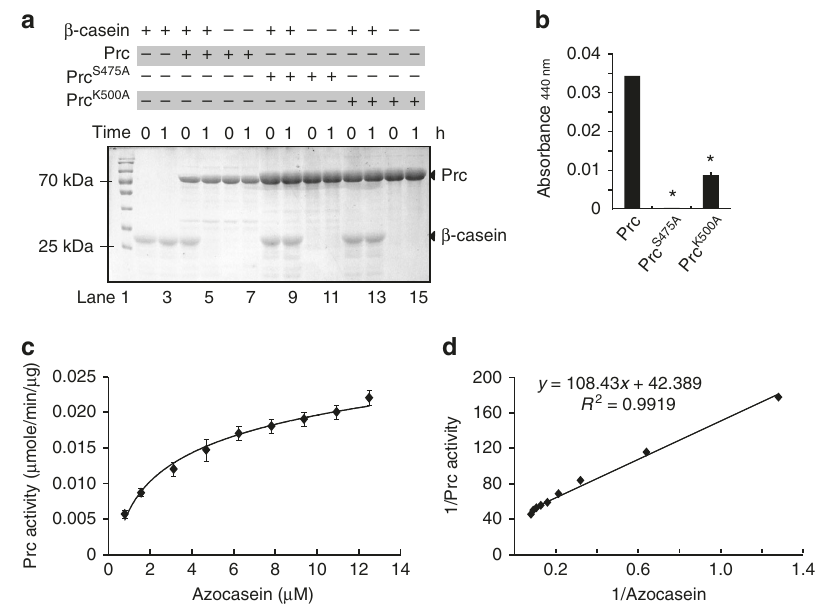
Fig. 2 Prc is a serine endopeptidase. a Prc degrades β -casein, and its endopeptidase activity is dependent on the Ser 475 and Lys 500 sites. β -Casein (41.5 μ M) was co-incubated with Prc (5 μ M) or its recombinant forms (Prc S475A and PrcK 500A , 10 μ M) at 28 °C for the indicated time. Reactions were stopped and analysed by SDS-PAGE together with Coomassie brilliant blue staining. b Quanti fi cation of Prc endopeptidase activity via degradation of the substrate azocasein. Azocasein (424 μ M) was mixed with Prc (25 μ M), and the reaction was carried out at 28 °C for 30 min. The optical absorbance was measured. Error bars represent standard deviations ( n = 3). Asterisks indicate signi fi cant differences (Student's t -test, P < 0.05). c and d The Michaelis – Menten kinetics of Prc activity for azocasein hydrolysis. The Michaelis – Menten curve c and Lineweaver – Burk plot d were obtained from the speci fi c reaction velocity of the hydrolysation of azocasein by Prc. The maximum speci fi c V max and K m values of the Prc activity were determined from the graphic representations. The data were derived from three independent experiments, and the goodness of fi t values ( R 2 ) is indicated. a – d , the experiment was repeated three